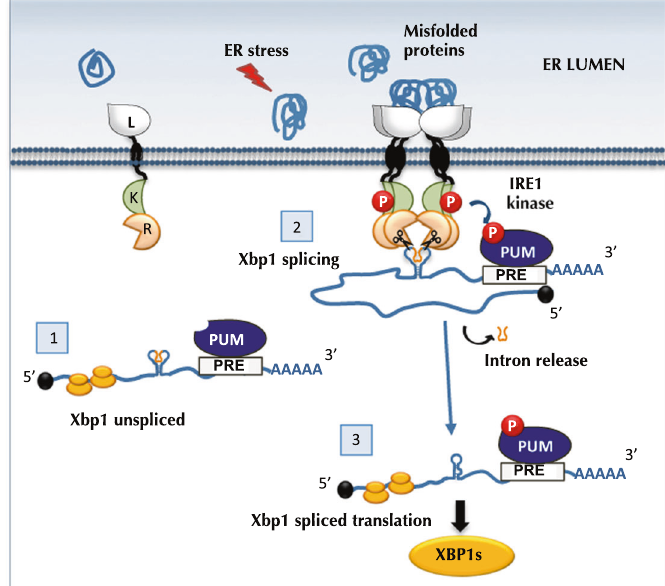
Fig. 6 Model for Ire1-controlled post-transcriptional regulation of Xbp1 by Pumilio. Step 1- In non ER stress conditions, Xbp1 unspliced is present in the cytosol and Pumilio (PUM) may bind to the PRE elements in the Xbp1 3 ′ UTR; Step 2- ER stress conditions lead to Ire1 autophosphorylation and PUM phosphorylation. Phosphorylated PUM protects Xbp1 spliced mRNA from Ire1 dependent decay, but does not impair Ire1 dependent Xbp1 splicing. Step